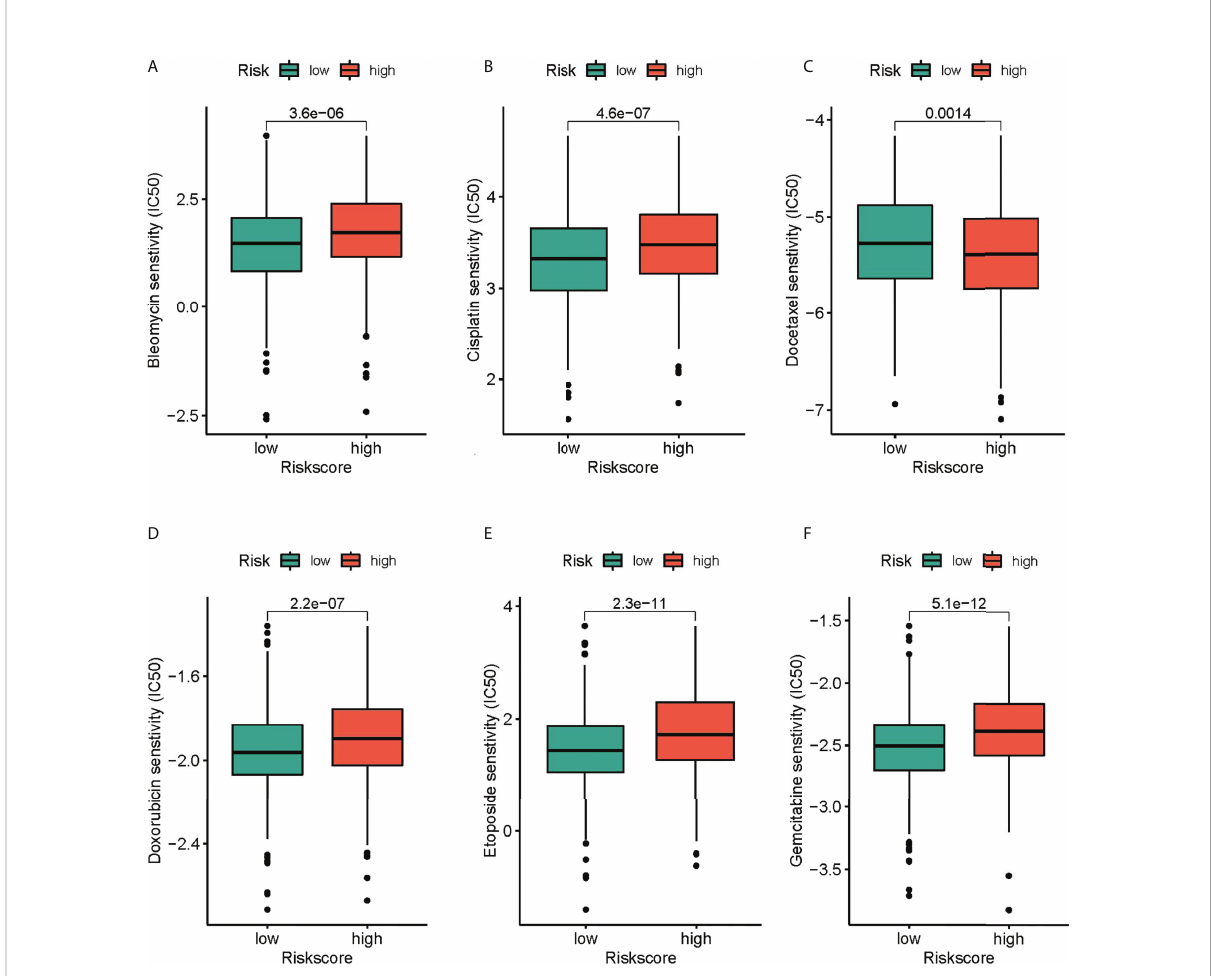
FIGURE 8 The differences in the chemotherapy response of common chemotherapy drugs between the high- and low-risk groups. (A) bleomycin, (B) cisplatin, (C) docetaxel, (D) doxorubicin, (E) etoposide, (F)